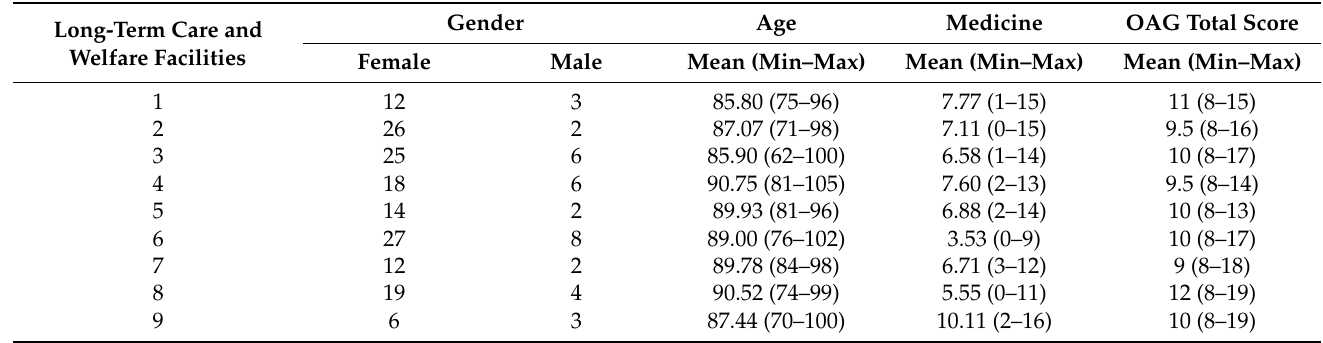
Table 2. Subject information at one year after baseline.